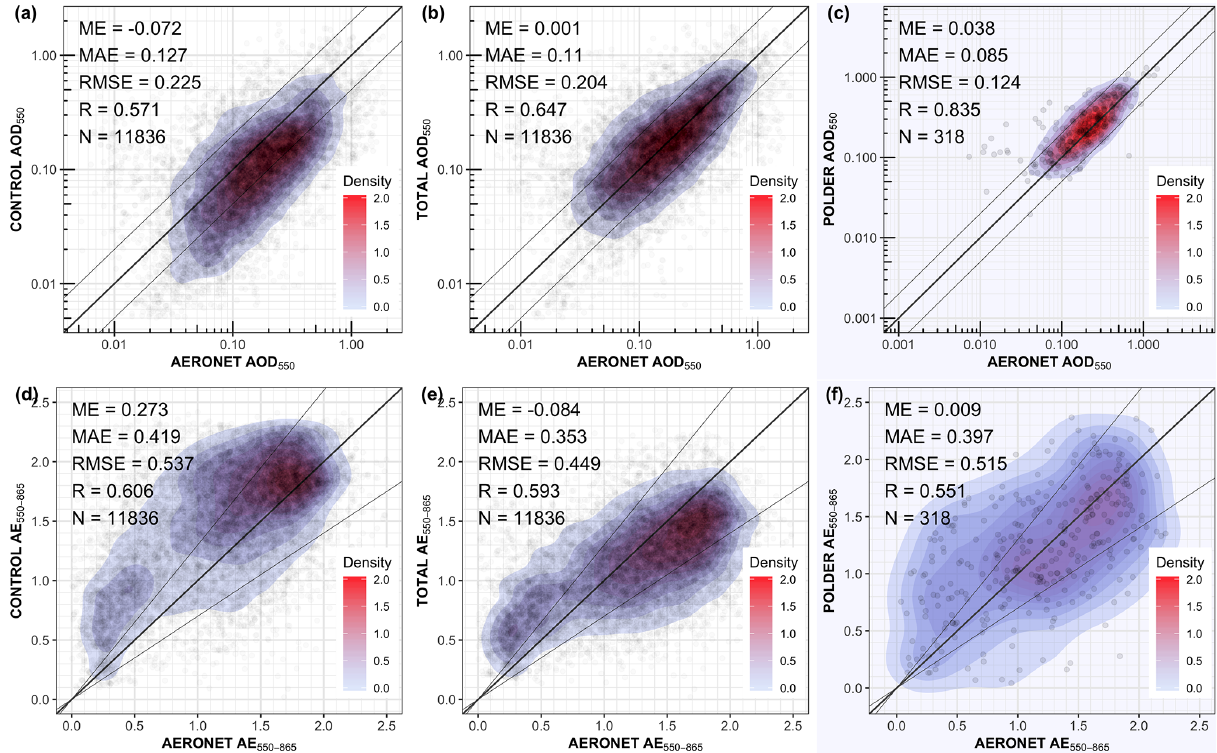
Figure 15. Comparison between the AERONET (direct-Sun V3 L2) and the CONTROL, TOTAL and POLDER experiments for AOD 550 (a– c) and AE 550 − 865 (d–f) .